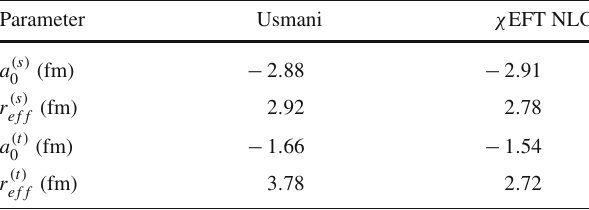
Table 1 The p– (cid:2) scattering parameters of the Usmani and the chiral potentials.Wedenotewith ( s ) and ( t ) thesingletandtripletstaterespec- tively. The scattering parameters for the Usmani potential are evaluated here [24]. The parameters for the the chiral potential are taken from [25] for a cutoff scale of 600 MeV Parameter